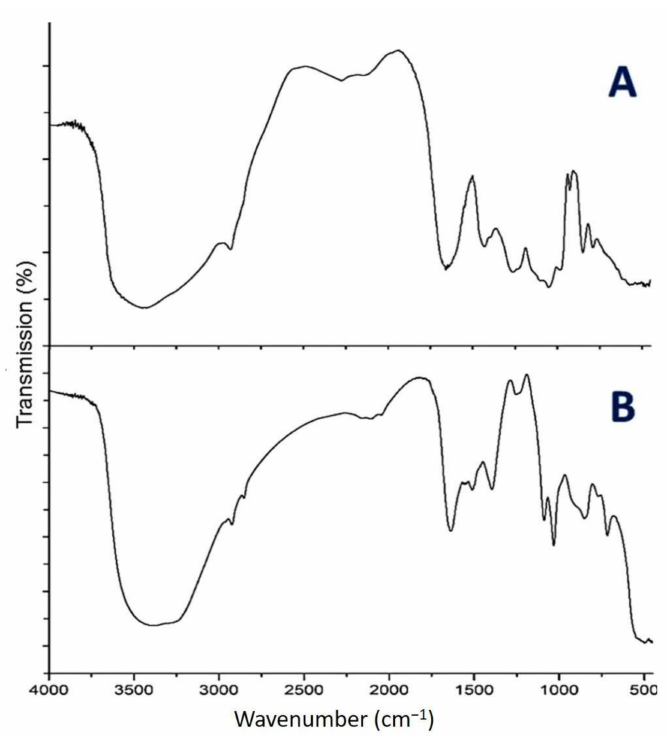
Figure 2. FTIR spectra of U. fasciata extract ( A ) and phycosynthesized ZnONPs with the extract ( B